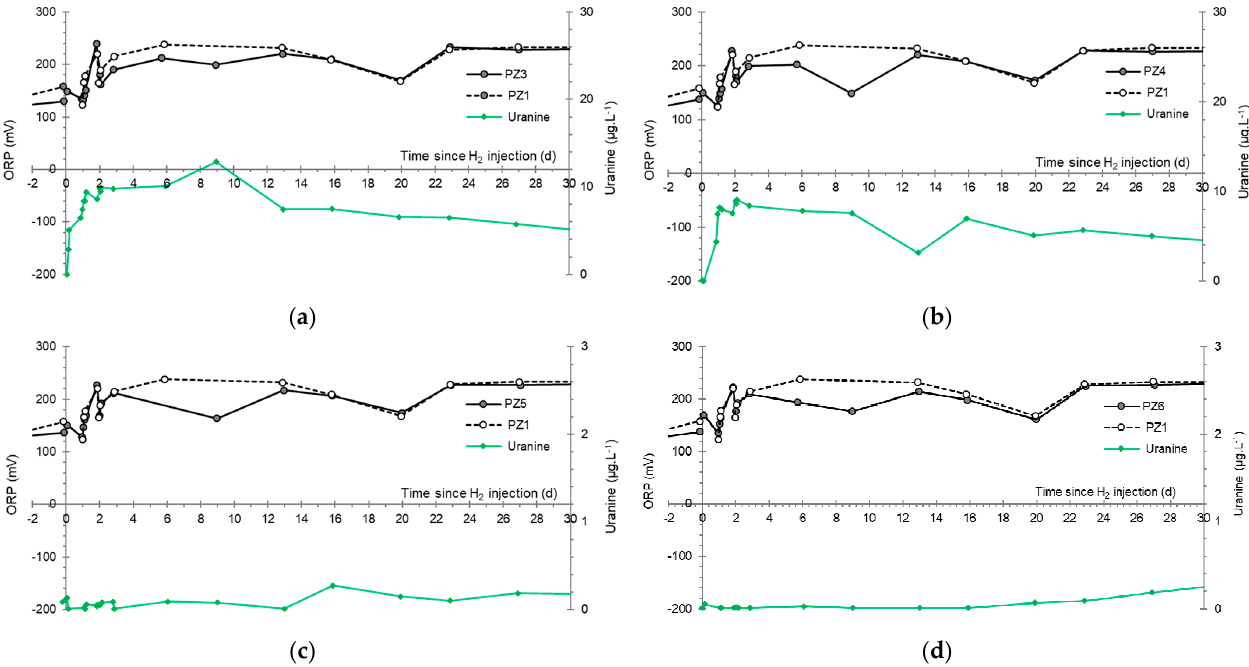
Figure 16. Comparative evolution of the oxidation-reduction potential and the tracer concentration at the other downstream piezometers: ( a ) PZ3 (10 m); ( b ) PZ4 (20 m); ( c ) PZ5 (30 m); and ( d ) PZ6 (60 m).